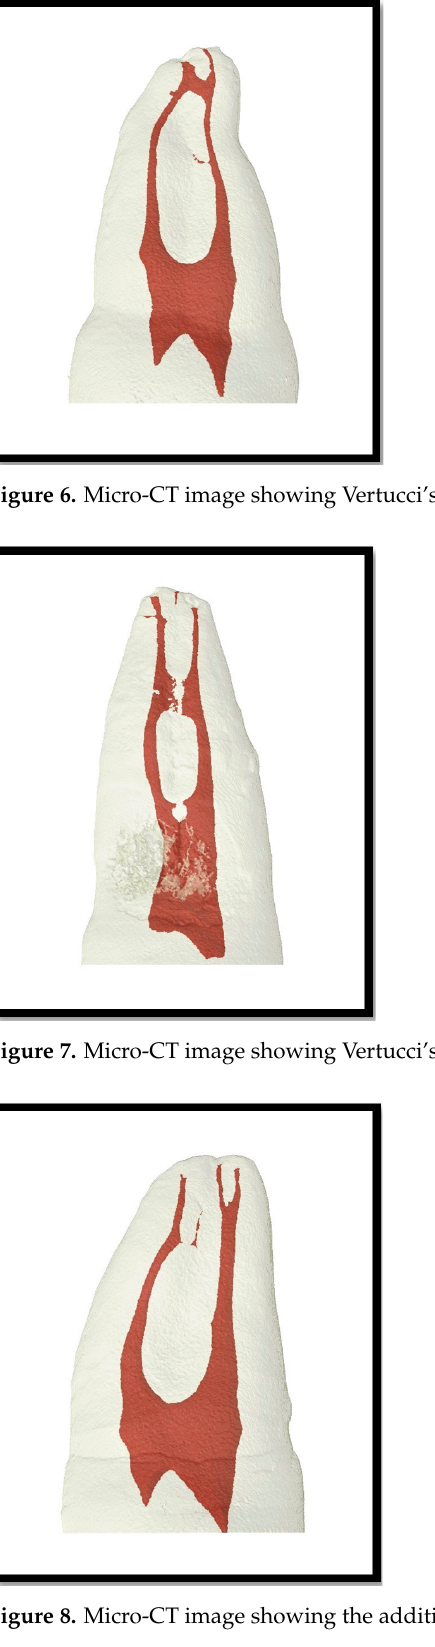
Figure 9. Micro-CT image showing the additional canal configuration (1-2-3). Figure 10. Micro-CT image showing the additional canal configuration (2-1-2-1).